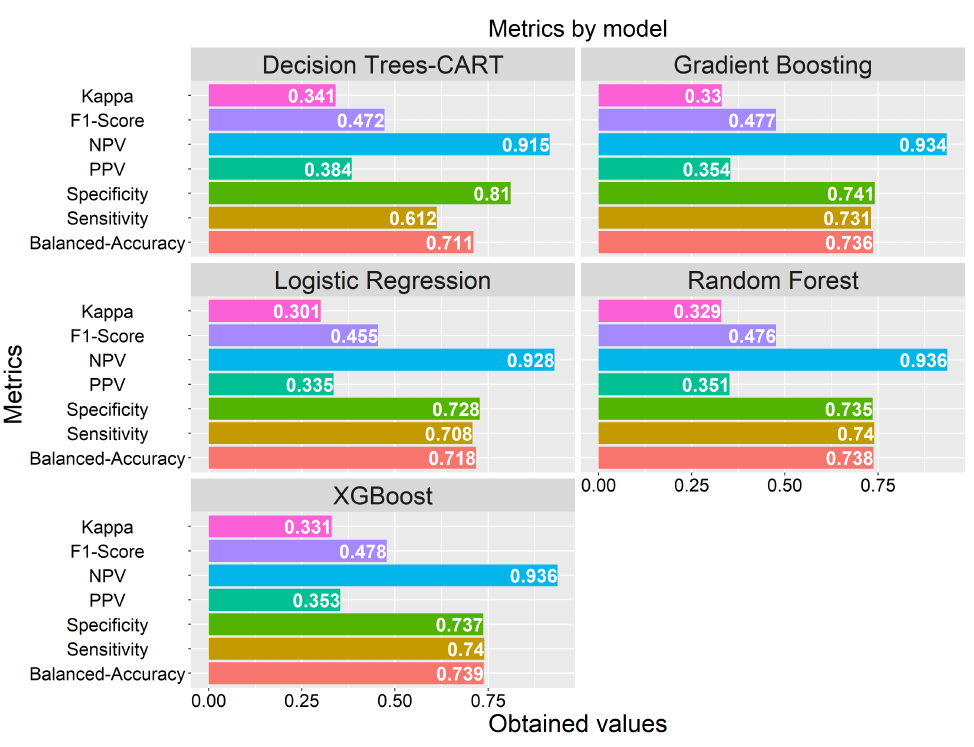
Figure 8. Metrics obtained on the test data set. We obtained similar values of F1-Score = 0.48 with XGBoost, Gradient Boosting, and Random Forest. Decision Trees-CART obtained a very close value of